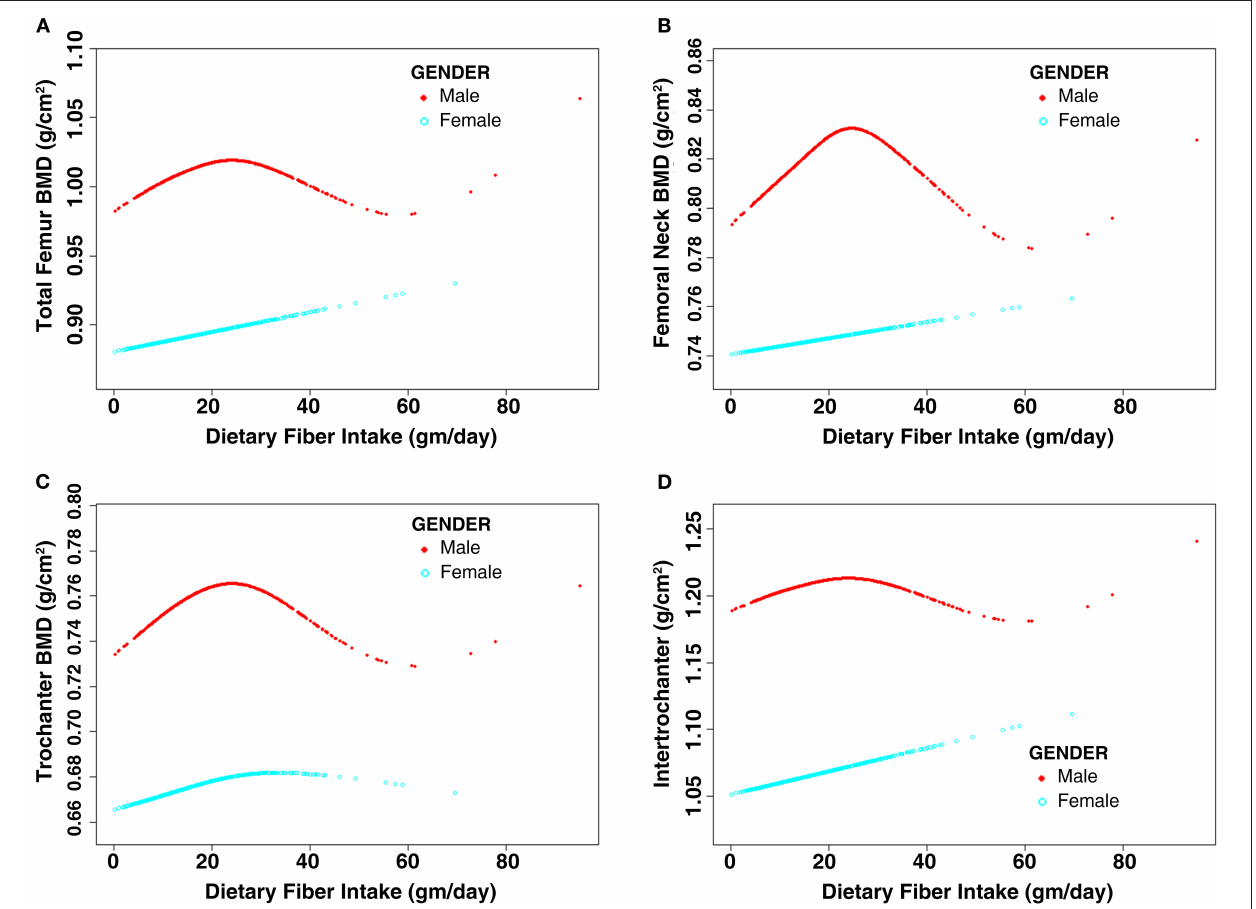
FIGURE 2 | Non-linear relationship between dietary fiber intake and femoral BMD stratified by sex. Age, race, education level, income level, BMI, smoking status, alcohol consumption, hypertension, diabetes, blood calcium level, serum 25-hydroxyvitamin D, RA, cancer, use of glucocorticoid, family history of osteoporosis, previous fractures, physical activity level, calcium intake level, and vitamin D intake level were adjusted. (A) Total femur BMD; (B) Femoral neck BMD; (C) Trochanter BMD; (D) Intertrochanter BMD. BMD, bone mineral density; BMI, body mass index; RA, rheumatoid arthritis.